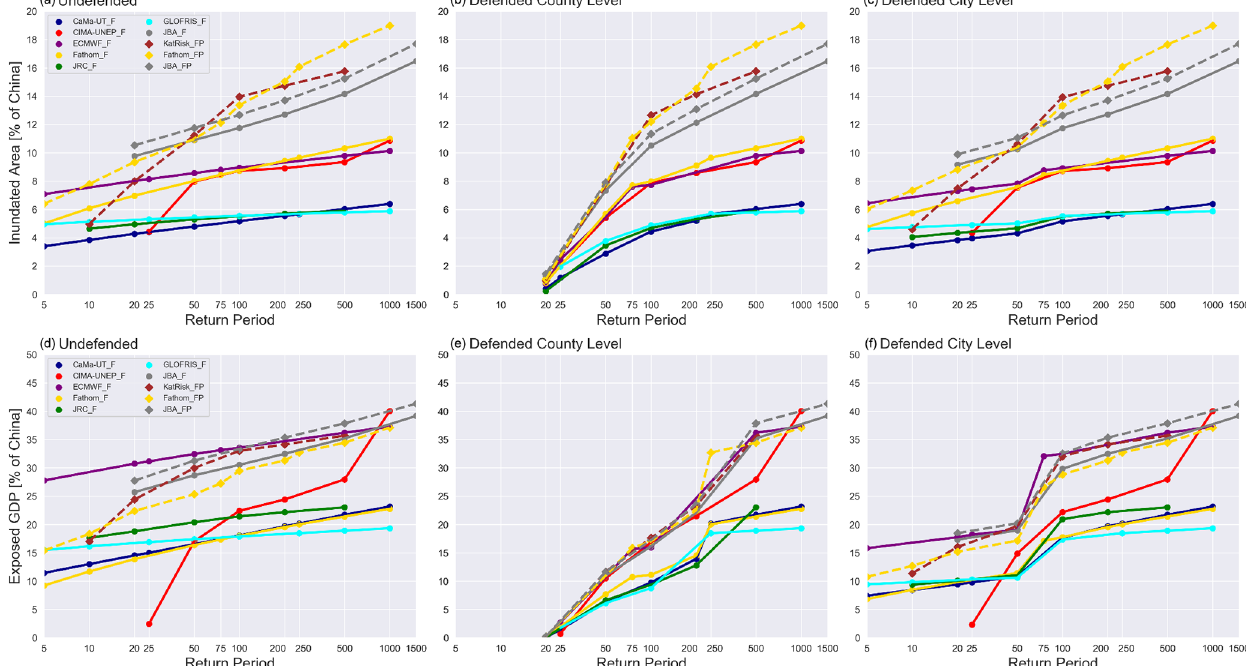
Figure 3. Results of multiple-return-period fluvial and combined hazard maps of eight GFMs. The results of the fluvial hazard maps (_F) are represented by a continuous line, and those of the combined hazard maps (_FP) are represented by an interrupted line. The RPs range from 5 to 1500 and are displayed on a logarithmic horizontal axis. (a) Percentage of the inundated area of China of undefended fluvial and combined hazard maps. (b) Percentage of the inundated area of China of county-level defended fluvial and combined hazard maps. (c) Percentage of the inundated area of China of city-level defended fluvial and combined hazard maps. (d) Exposed-GDP percentage of China of undefended fluvial and combined hazard maps. (e) Exposed-GDP percentage of China of county-level defended fluvial and combined hazard maps. (f) Exposed-GDP percentage of city-level defended fluvial and combined hazard